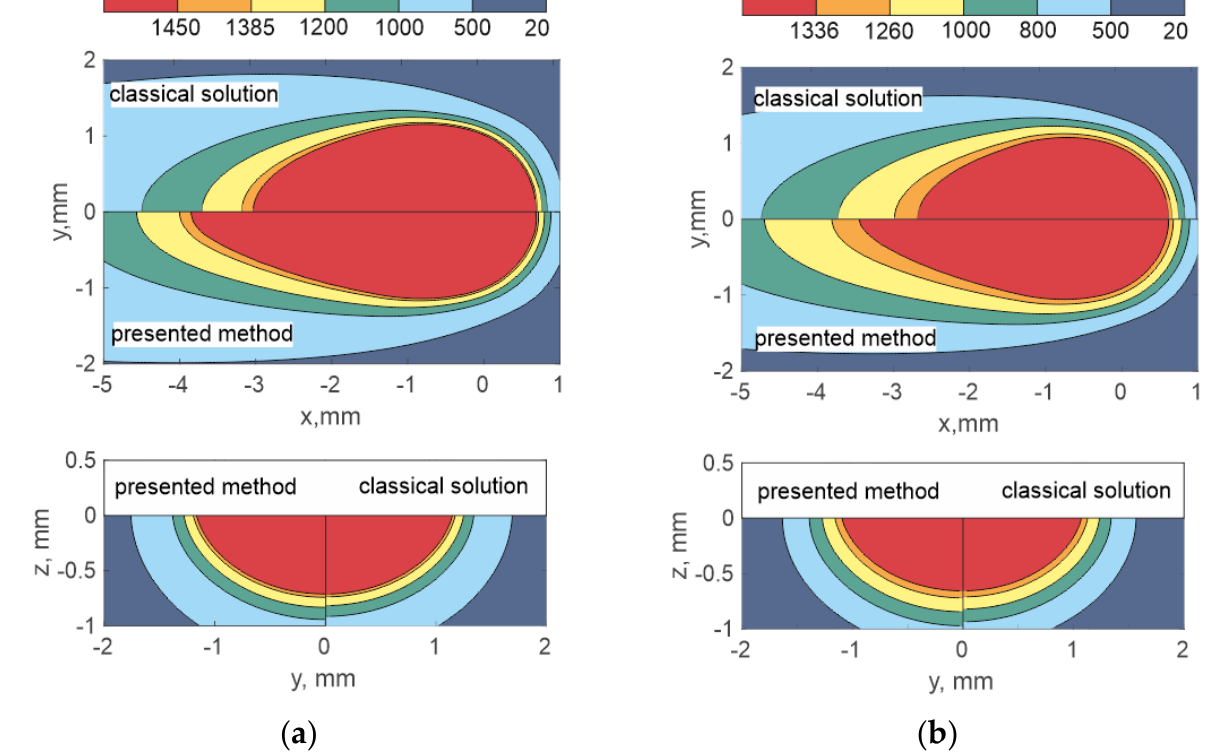
Figure 3. Estimated temperatures during laser deposition: ( a ) SS316L; ( b ) Inconel 718.